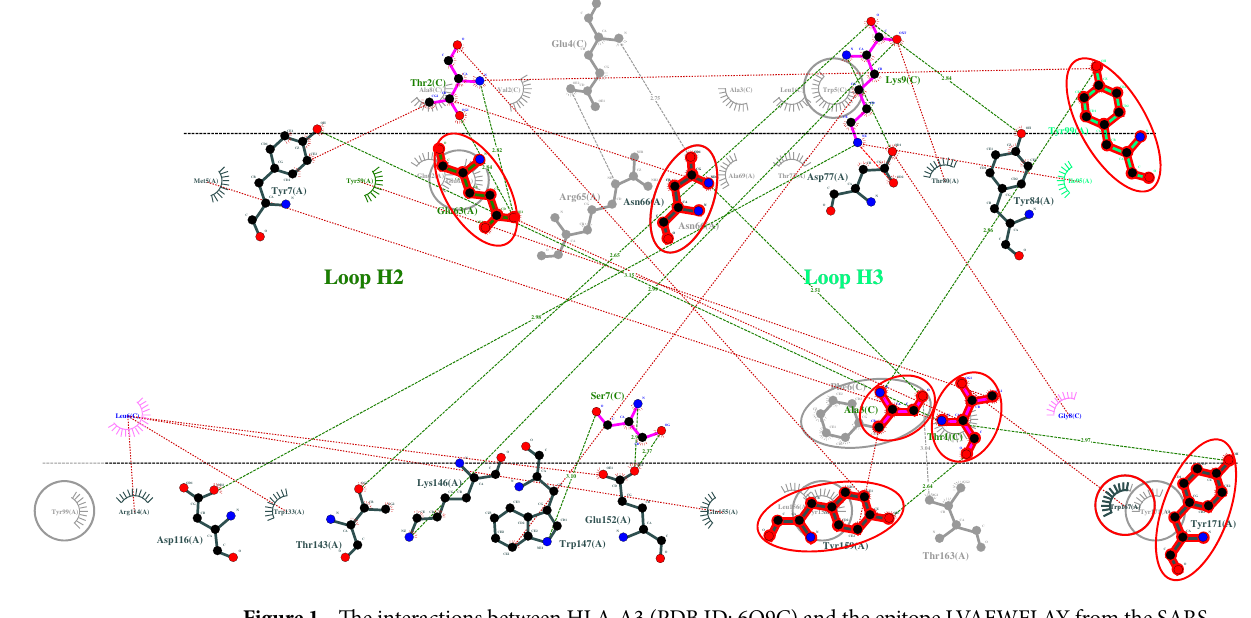
Figure 1. The interactions between HLA-A3 (PDB ID: 6O9C) and the epitope LVAEWFLAY from the SARS- CoV-2 proteome.